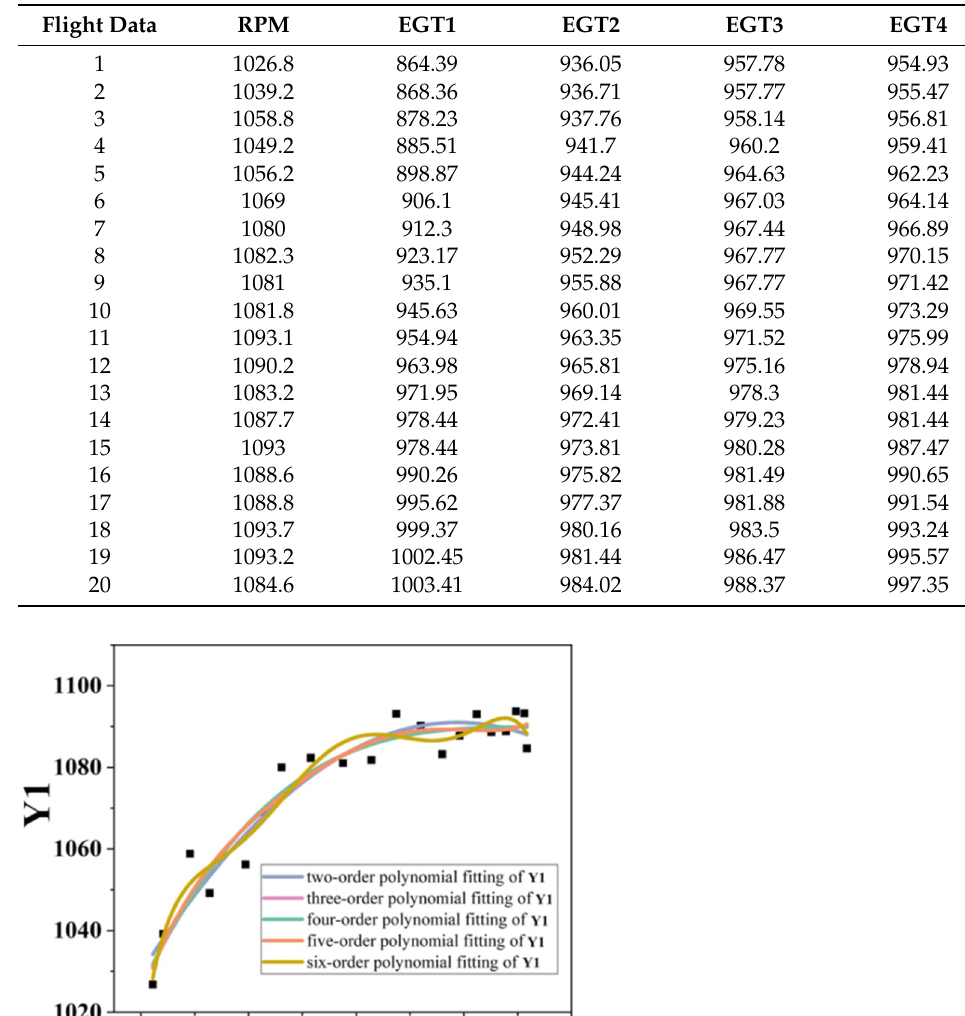
Table 2. Partial raw flight data RPM and four different EGT.